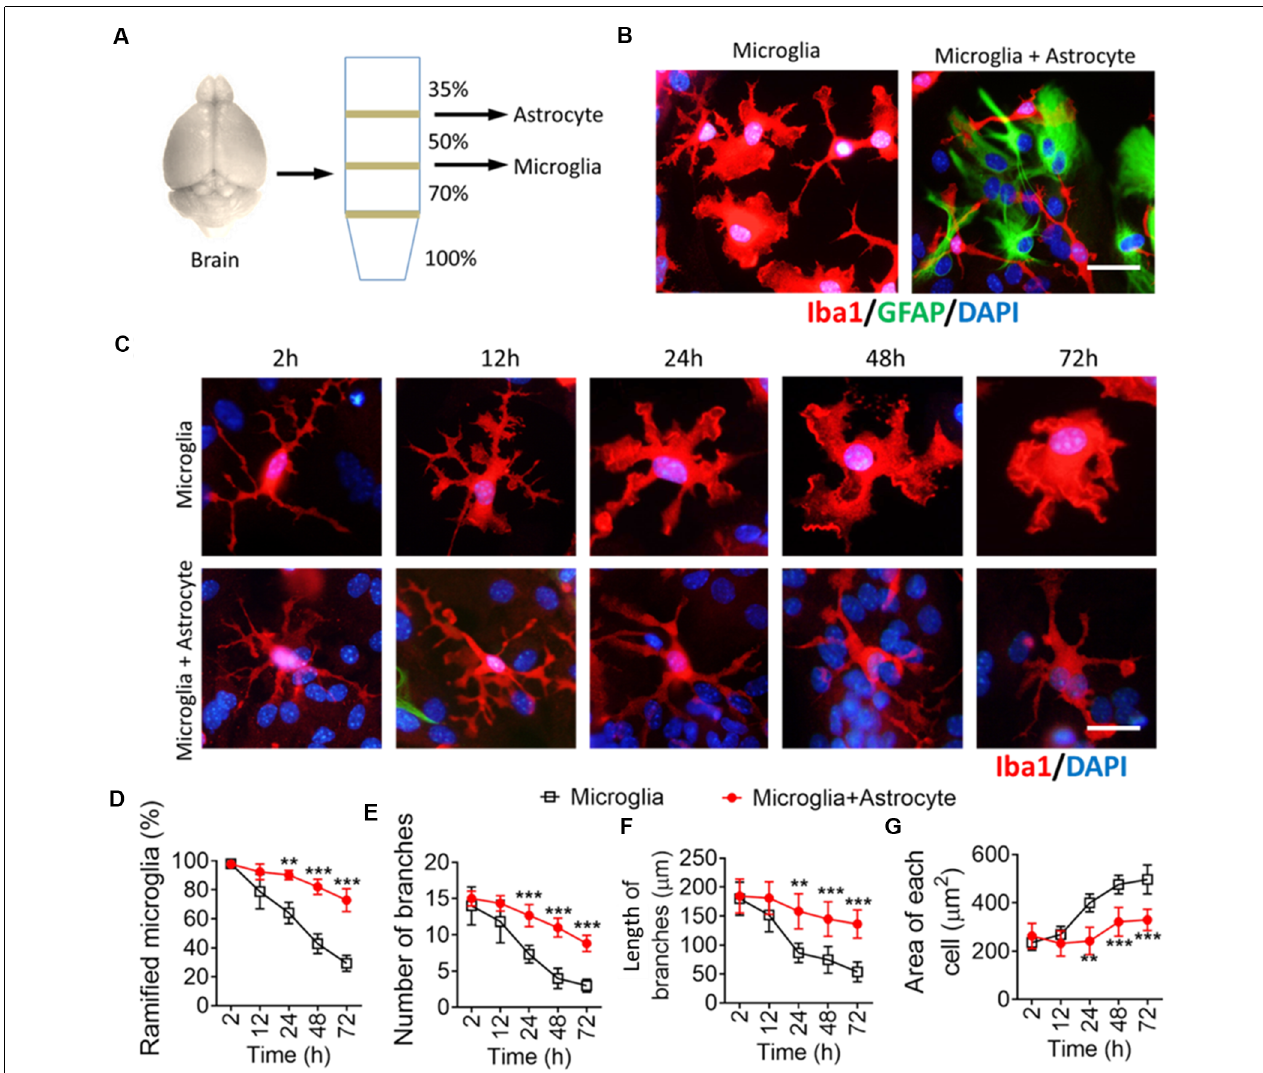
FIGURE 4 | Astrocytes maintain a multibranched structure of microglia isolated from the brain. (A) Schematic diagram showing a Percoll density gradient for the isolation of microglia and astrocytes from the mouse brain. (B) Representative immunofluorescence micrographs showing morphological differences in microglia isolated from the brain cultured alone or cocultured on an astrocyte monolayer. Microglia were labeled by Iba1 (red), astrocytes were labeled by GFAP (green), and nuclei were labeled by DAPI (blue). Scale bar, 10 µ m. (C) Time series of fluorescence micrographs showing morphological changes in microglia isolated from the brain after culture alone or coculture on an astrocyte monolayer. Microglia were labeled by Iba1 (red) and nuclei by DAPI (blue). Scale bar, 10 µ m. (D–F) Time course of percentage of ramified microglia (D) , number (E) , and length (F) of branches, and cell body area of microglia (G) . Results of each group were obtained from four independent samples, and 5–6 micrographs were collected from each sample. All Iba1 + cells in each micrograph were measured. Data are presented as mean ± SEM ( n = 4). ** P < 0.01 and *** P < 0.005 vs. microglia (two-way ANOVA with